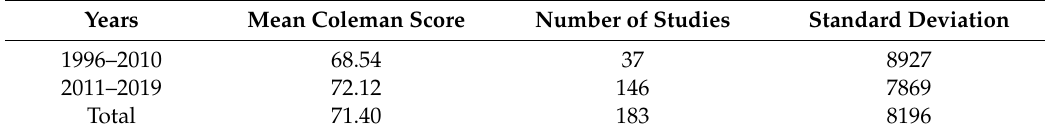
Table 1. Mean Coleman score in articles written before 2010 and articles written after 2010. Years